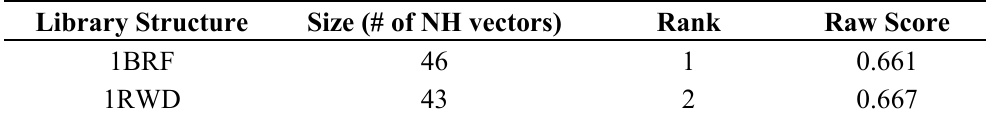
Table 3. Results of structure identification from unassigned experimental RDC data for the protein PDBID:1RWD.